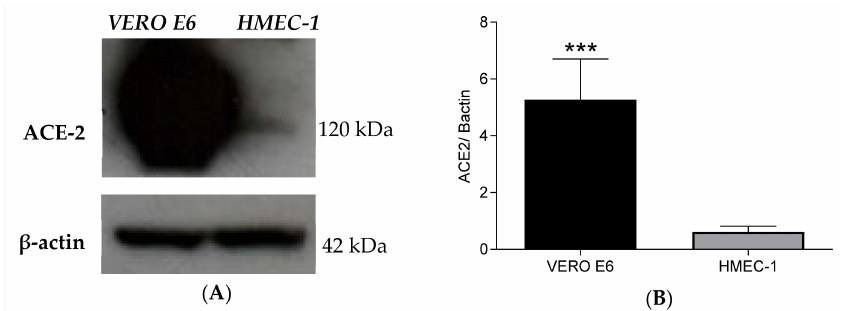
Figure 1. Detection of ACE2 protein in VERO E6 and HMEC-1 cells. ( A ) Western blot analysis showing ACE2 (about 120 kDalton) in VERO E6 and HMEC-1 cell lines. ( B ) Quantification of ACE2 intensity. ACE2 expression was normalized versus β -actin expression. Statistical significance was determined using t -test, between HMEC-1 and VERO E6 (*** p value <